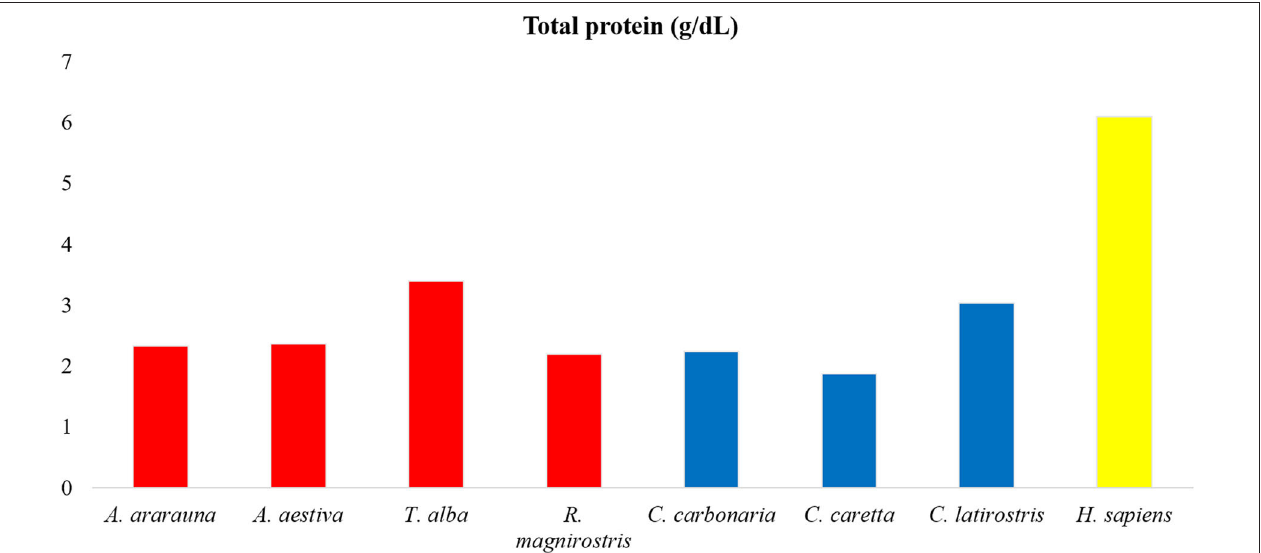
FIGURE 1 | Amounts of total proteins in tears of birds, reptiles, and humans. Note high protein content in human tears, followed by Tyto alba and Caiman latirostris